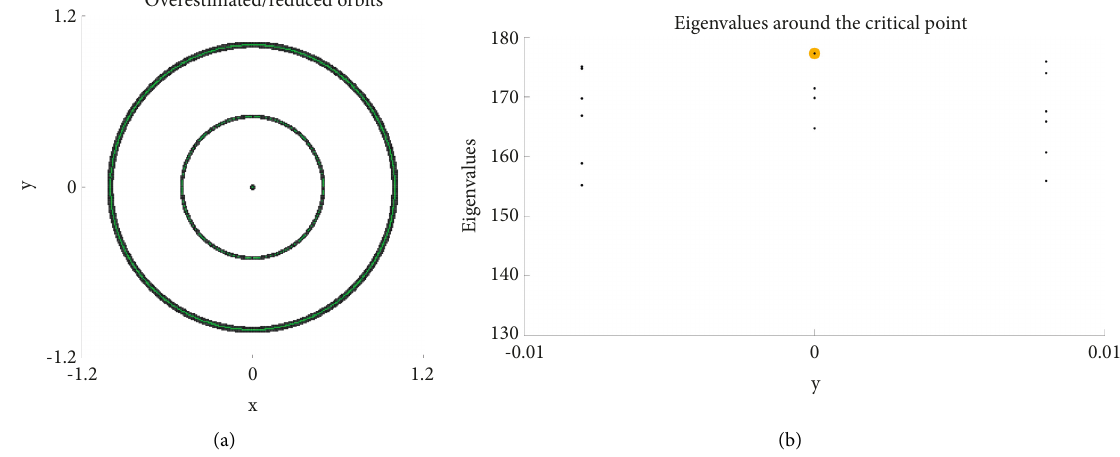
􏽥 X 0 of the v, 14 is plotted in black. Our refined approximation and points from the overestimation 􏽥 X 0 at the inner orbit if one 0 . 8